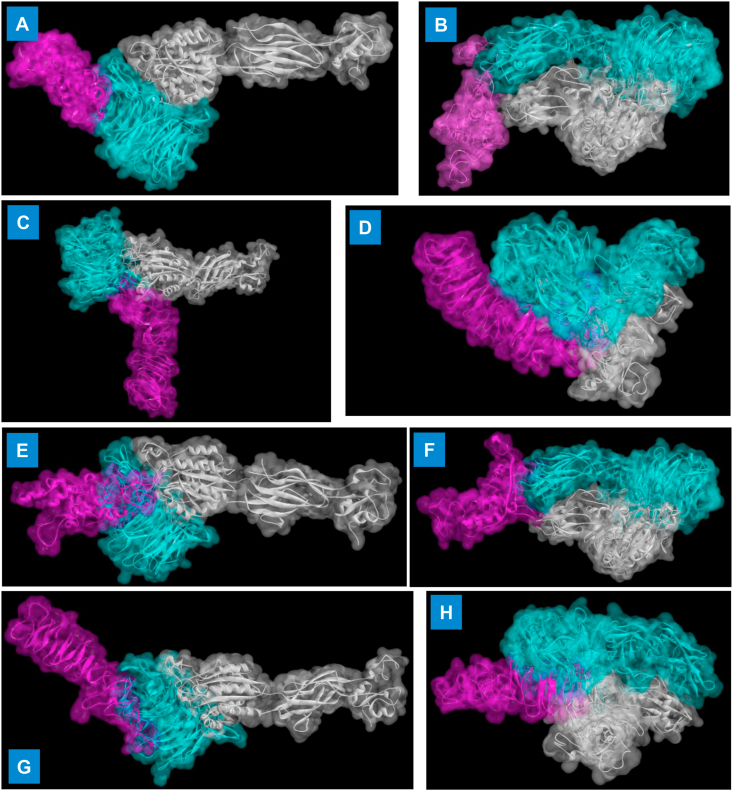
Docked complex of multi-subunit vaccine constructs with integrin receptor. A. Construct1 interaction with αIIbβ3 B. Construct 1 with αVβ3 C. Construct 2 with αIIbβ3 D. Construct 2 with αVβ3 E. Construct 6 with αIIbβ3 F. Construct 6 with αVβ3 G. Construct 7 with αIIbβ3 H. Construct 7 with αVβ3. Integrin receptor chain A and B has been shown in cyan and silver color, respectively, whereas magenta color represents the multi-epitope vaccine constructs in the docked complex.